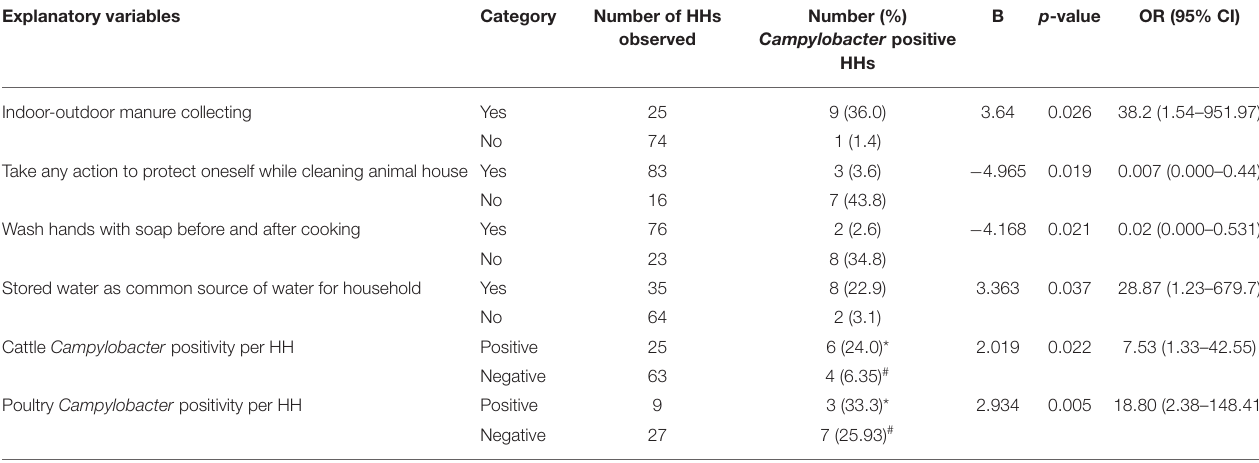
TABLE 4 | Multivariable logistic regression analysis of significantly associated explanatory variables for human Campylobacter species positivity. Explanatory variables